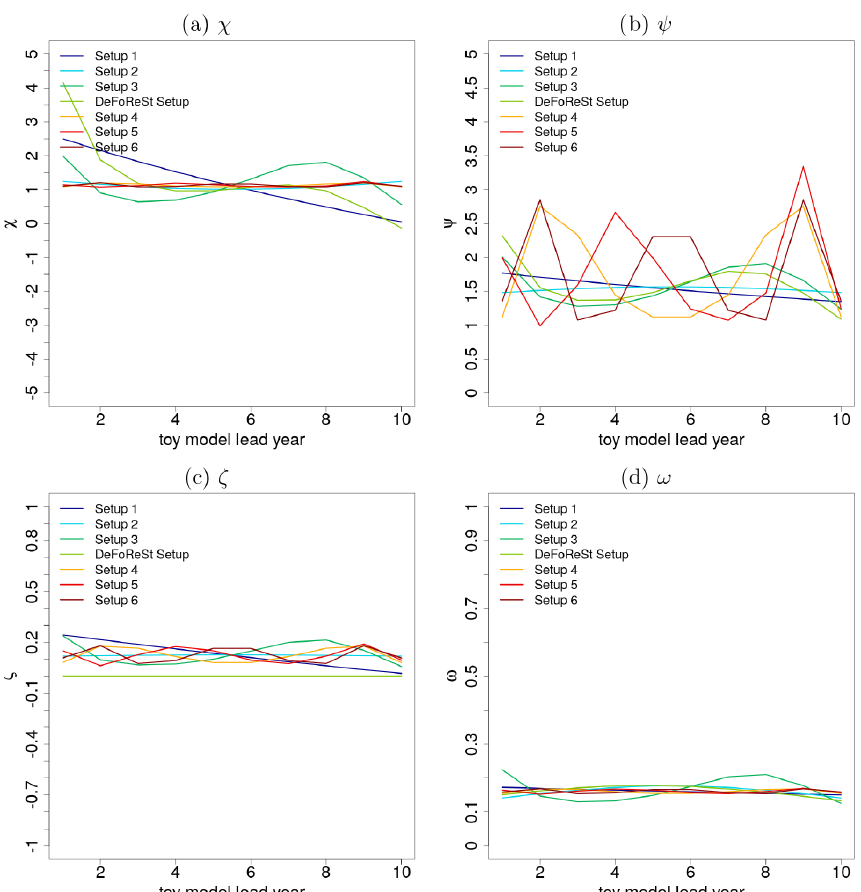
Figure 4. χ(t,τ) (a) and ψ(t,τ) (b) which are related to the unconditional and conditional bias, as well as ζ(t,τ) (c) and ω(t,τ) (d) which are related to the unconditional and conditional dispersion of the ensemble spread for the different toy model setups (colored lines) as a function of lead year τ with respect to start year t =